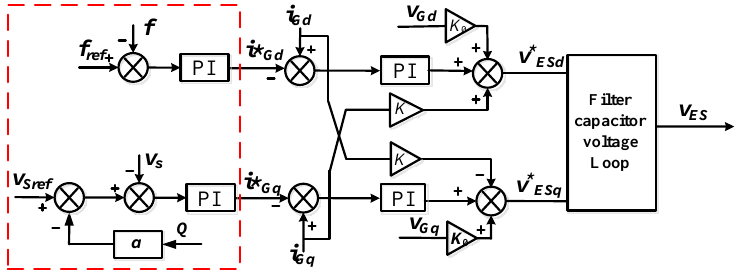
Figure 7. Proposed hierarchical control for ES-2.